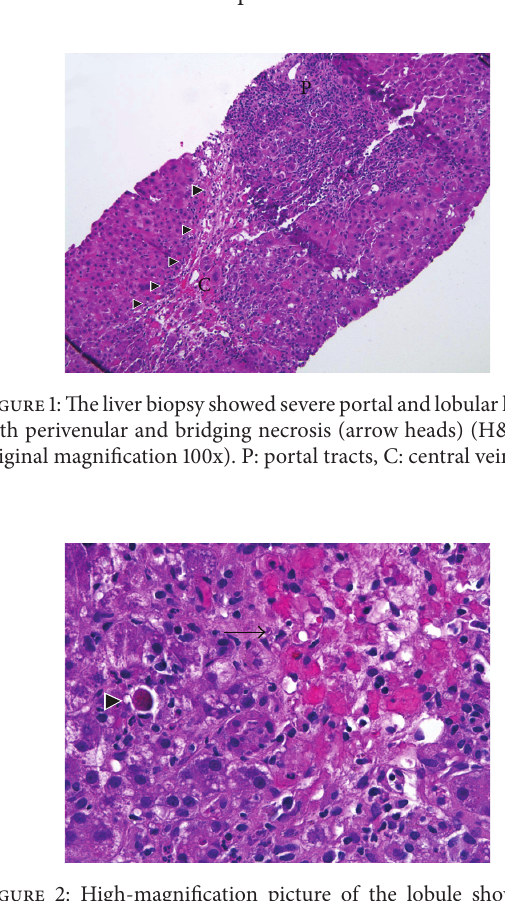
Figure 2: High-magnification picture of the lobule showing an area of centrizonal confluent necrosis (arrow) and adjacent viable parenchyma. Scattered mononuclear inflammatory cells and an apoptotic hepatocyte are present in the viable parenchyma (H&E stain, original magnification